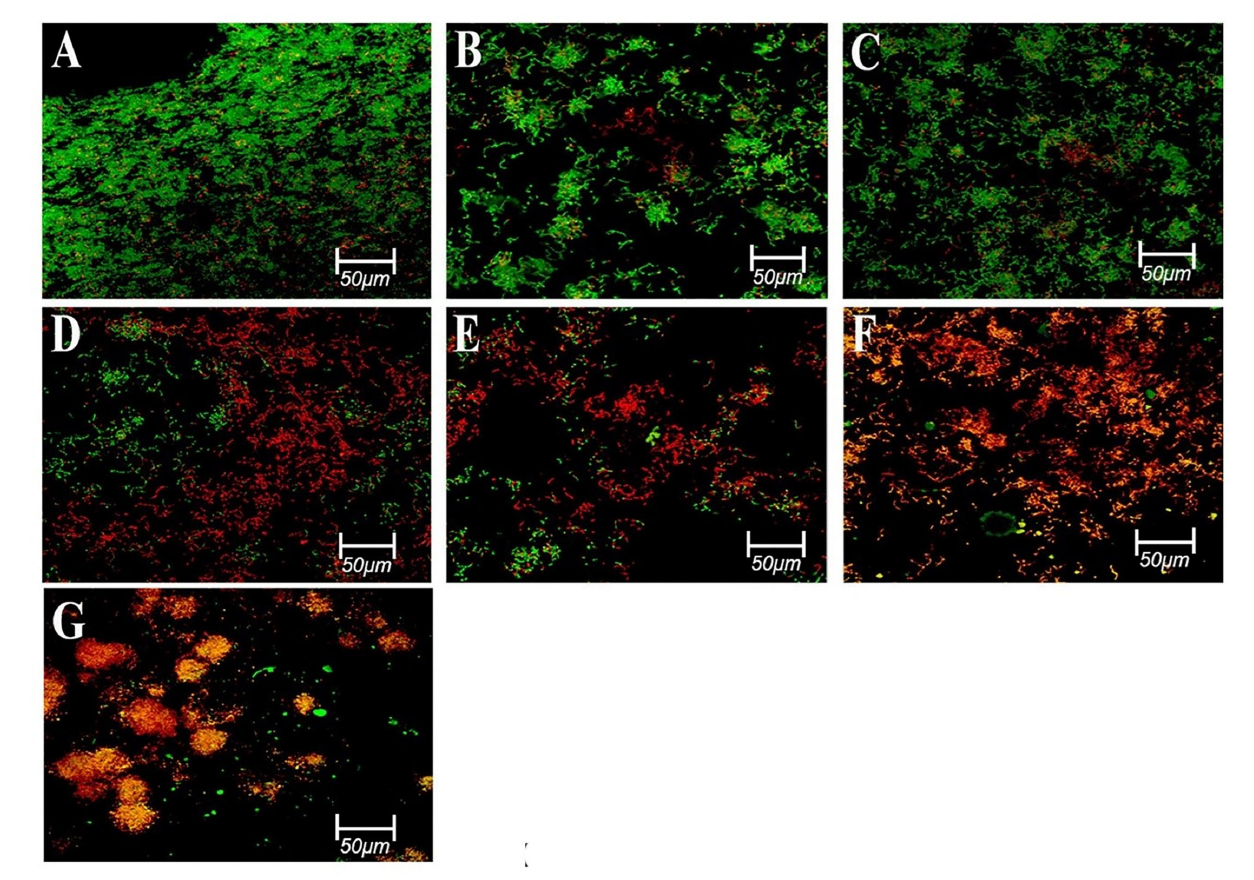
FIGURE 6 | Representative confocal images of E. faecalis biofilms of different groups stained using a live/dead bac light bacterial viability kit; (A,B) control after 3 days; (C) control after 7 days; (D) 2% CHX after 7 days; (E) 41% Ca(OH)2 after 7 days; (F) 2%k21 after 3 days; and (G) 2%k21 after 7 days. Excitation was performed at λ = 514nm. Green indicates a high level of bacterial viability in control specimens. Most of the red fluorescence in 2%k21 specimens indicating dead cell population. Scale bar = 50 µ m. Reprinted from Kok et al.